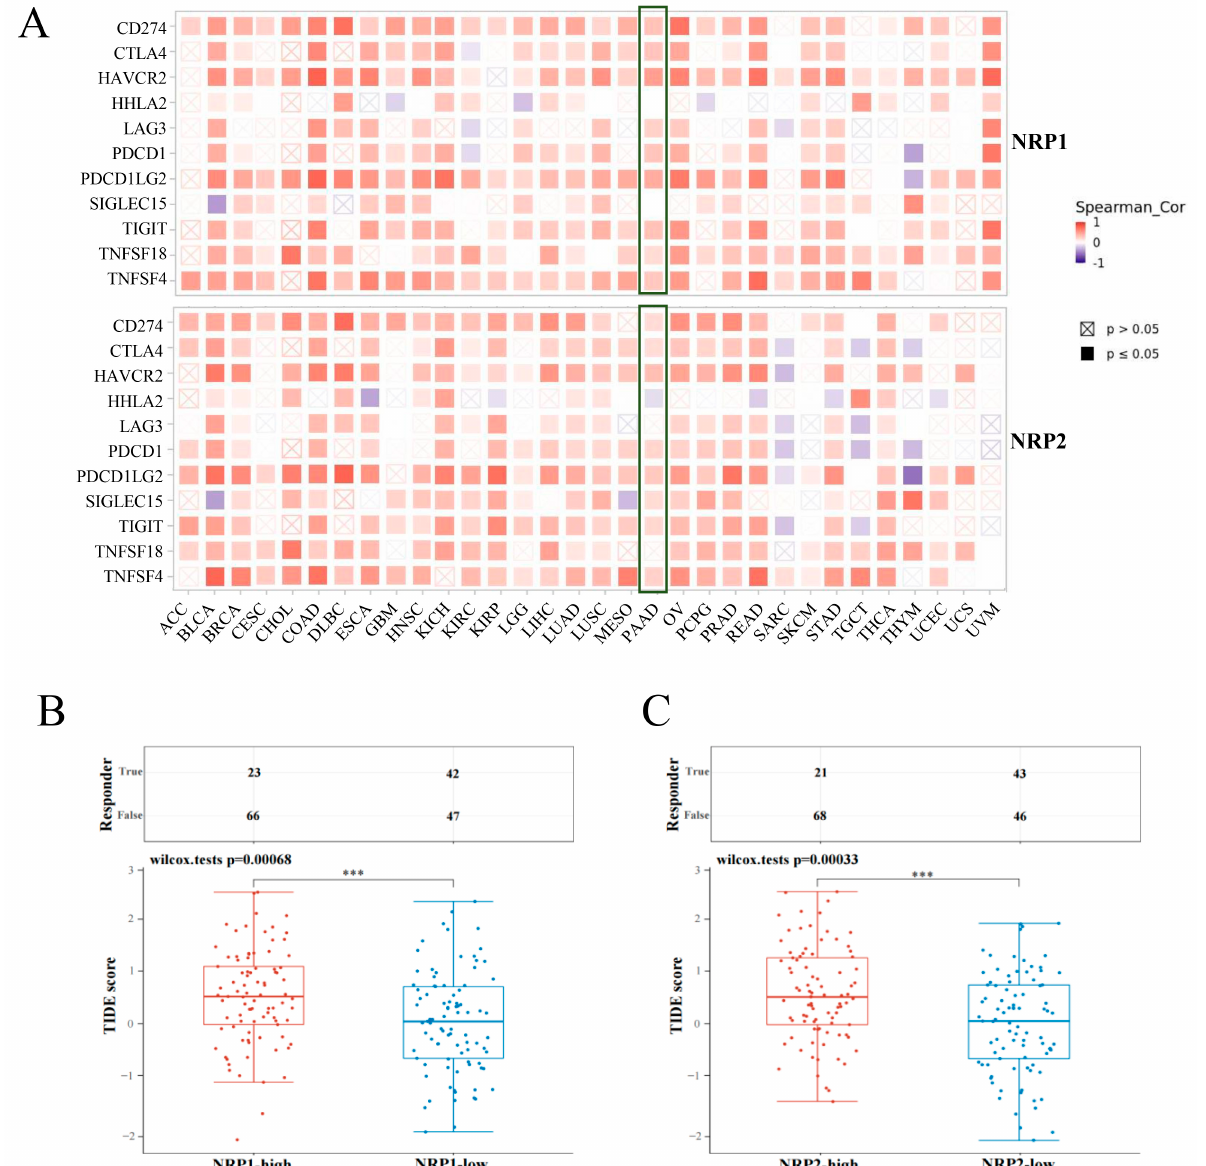
Figure 5. Tumor immunology analysis. ( A ) The heatmaps represent the correlation between NRP expression and immune check point expression in pan-cancer. Solid black square, p ≤ 0.05; hollow block with cross, p > 0.05; The “large green box” data belongs to PAAD. The correlation between NRP1 ( B ), as well as NRP2 ( C ), and ICB response prediction, and statistical tables of the ICB response and TIDE score in NRP high and low groups in PAAD were conducted. The higher the TIDE score, the poorer the efficacy of ICB, and the survival time after ICB treatment was short. *** p < 0.001.